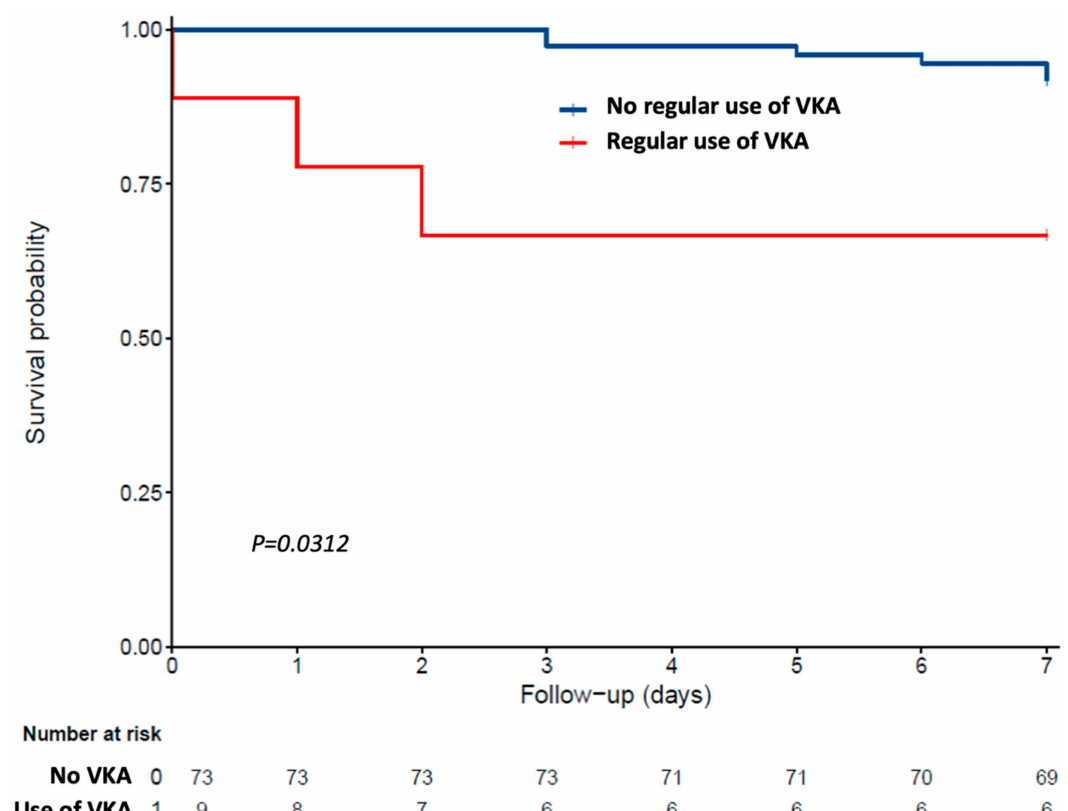
Figure 1. Kaplan–Meier estimates of the cumulative probability of COVID-19 participants’ survival according to the regular use of vitamin K antagonist (VKA) prior to COVID-19 ( n =